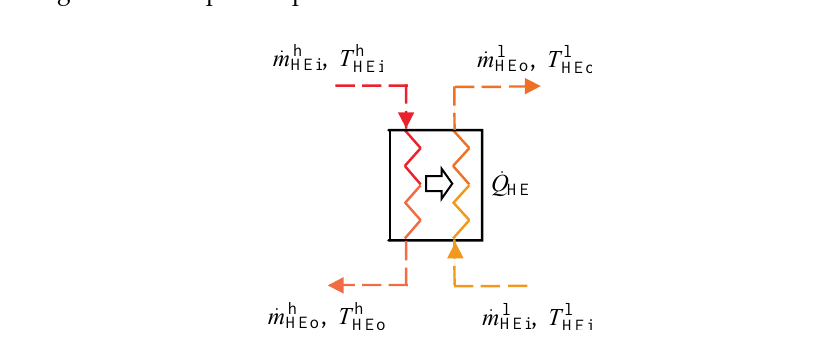
Figure A4. Model for heat exchanger.